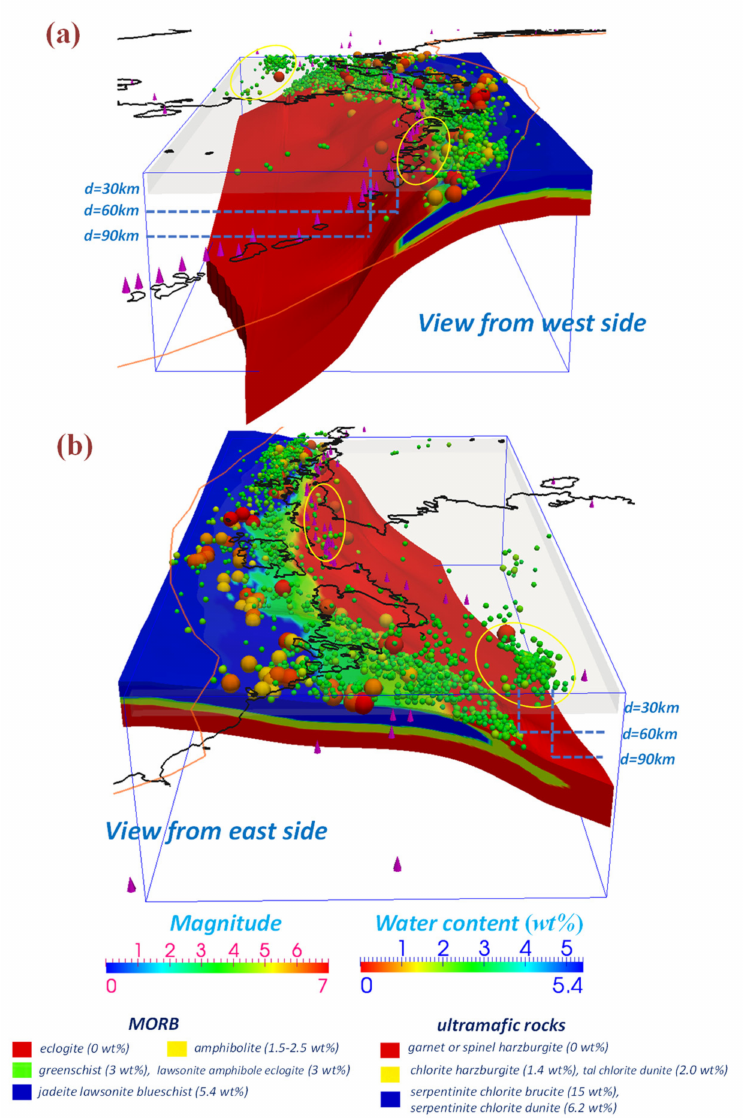
Figure 4. Wedge earthquakes in Alaska. Slab color indicates water content (wt %) distribution. The colored spheres indicate all M > 3 earthquakes (IRIS) in the North American plate from 1 January 2000 to December 2010 and all M > 5.5 earthquakes from 1 January 1900 to December 2000 (Centen- nial Database). The black curve on the surface represents the coast. Red cones indicate active arc volcanoes [40]. Yellow ellipses indicate clustered continental wedge earthquakes. ( a ) View of the 3D model from the west. ( b ) View of the 3D model from the